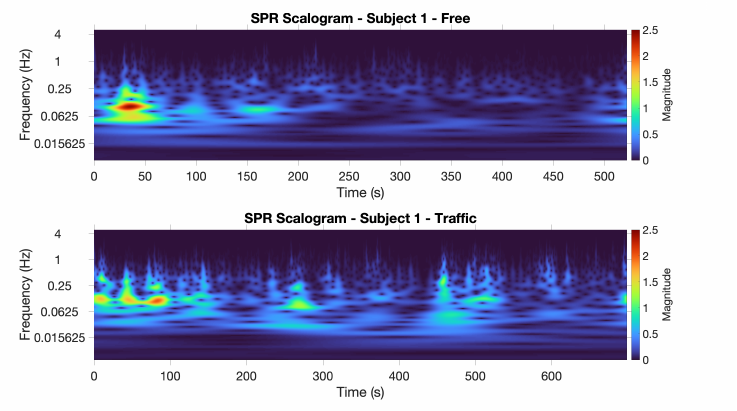
Figure 4. SPR scalograms for Subject 1: non-traffic scenario ( top ) and traffic scenario ( bottom ).